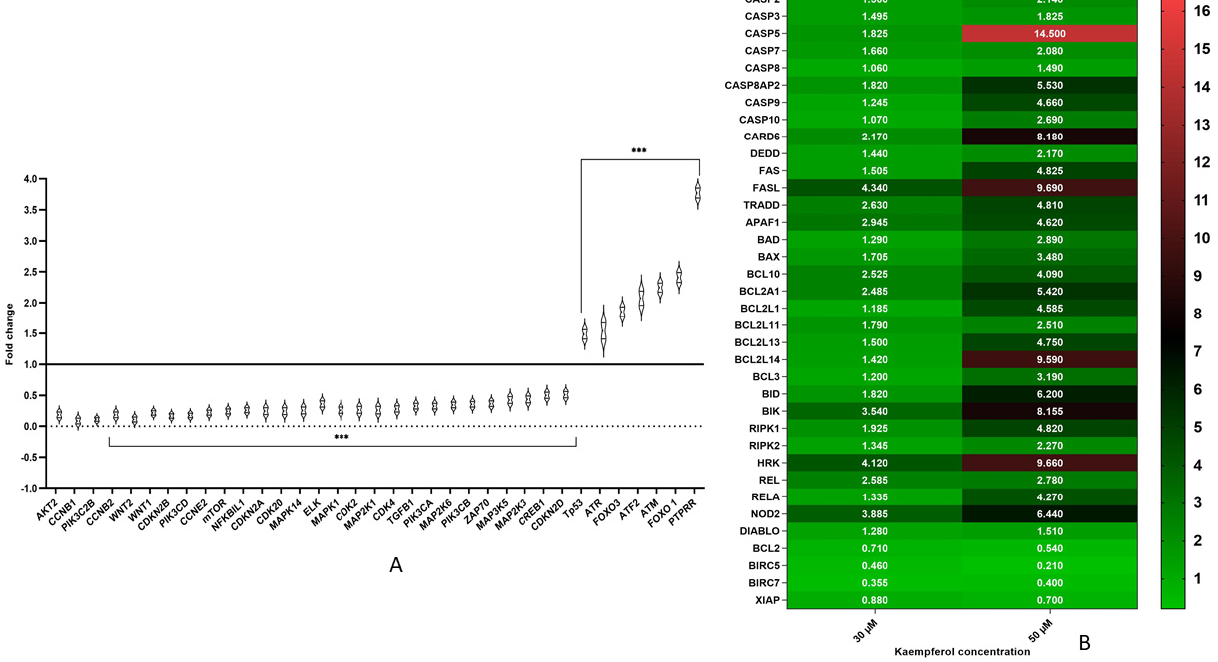
Figure 3. Transcripts’ expression analysis ( A ) Graphical representation of fold change showing downregulation of various cell cycle regulatory genes, PI3K/AKT, MAPK and WNT pathways signalling molecules, while upregulation in TSGs’ expression compared to control followed by treatment with kaempferol (50 µM for 48 h). ( B ). Heat map demonstrating the increased and decreased expression of pro-apoptotic and anti-apoptotic genes, respectively, alongside upregulation of caspases, extrinsic receptors and ligands related to intrinsic and extrinsic pathways followed by kaempferol treatment (30 and 50 µM) at 48 h. The data are expressed as the mean ± standard deviation of three independent experiments. Statistically significant differences are marked by asterisks: Two way-ANOVA * represents p < 0.05; ** represents p < 0.01, *** represents p < 0.001.